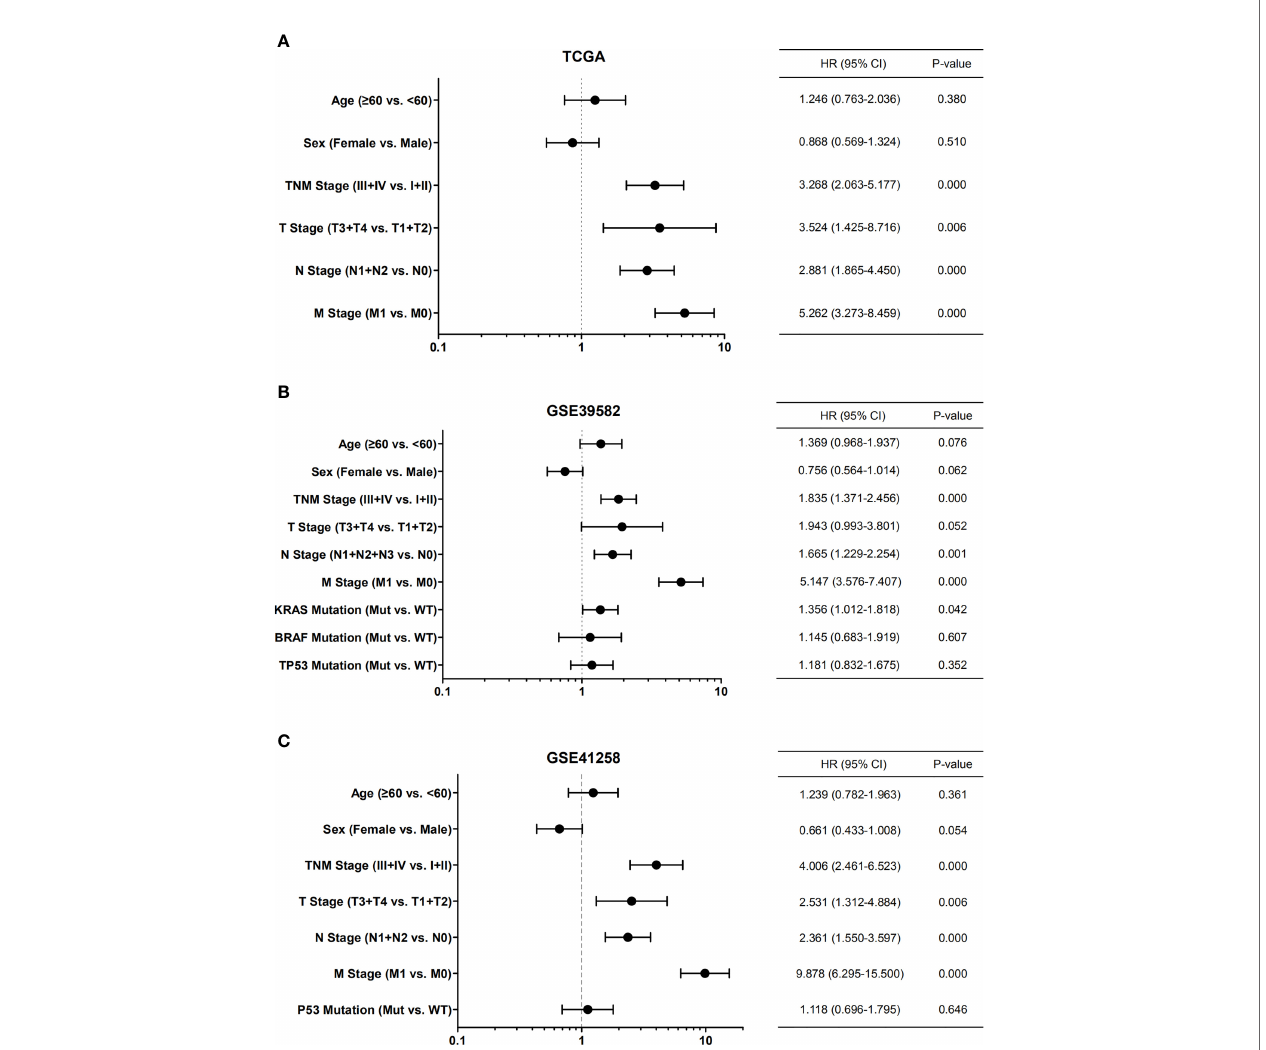
FIGURE 4 | Forest plots showing the univariate Cox regression analysis of overall survival and clinical features of patients with colon cancer from TCGA (A) , GSE39582 (B) , and GSE41258 (C) datasets. Hazard ratio (HR) with con fi dence interval (CI) is plotted on the x-axis. TNM, tumor-node-metastasis; Mut, mutant; WT, wild